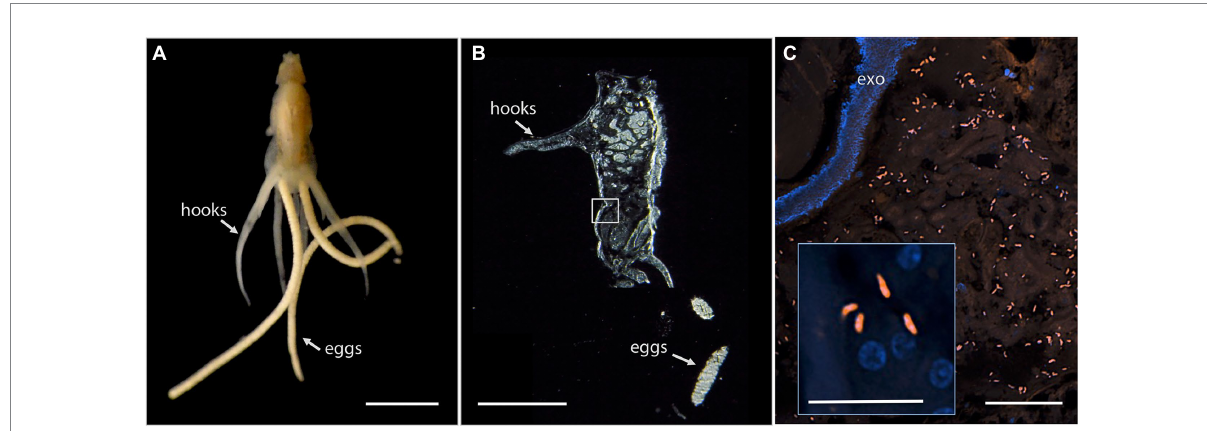
FIGURE 4 Fluorescent visualization and localization of Vibrio in (A) the parasitic copepod Lernanthropus latis , with clasping hooks and egg strings noted. Image taken with a Pentax WG-III handheld camera. Scale bar 2 mm. (B) Cross section of the specimen after being embedded in Steedman’s wax and sectioned. Scale bar 2 mm. (C) A Vibrio -specific fluorescent probe revealed comma-shaped bacterial cells, shown in orange via Cy3, within the digestive lumen space among bloodmeal. Scale bar 20 μ m. (inset) A magnified view of the Vibrio cells, near copepod nuclei, shown in blue